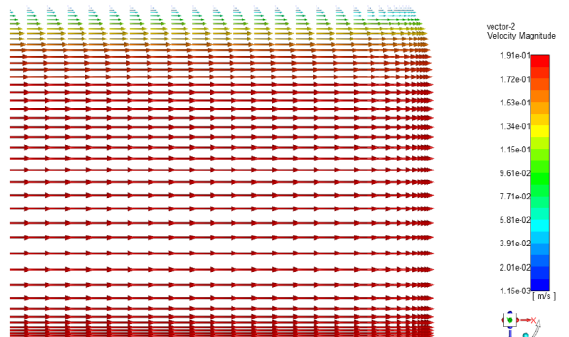
Fig. 9. Velocity magnitude profile parallel to ZX plane